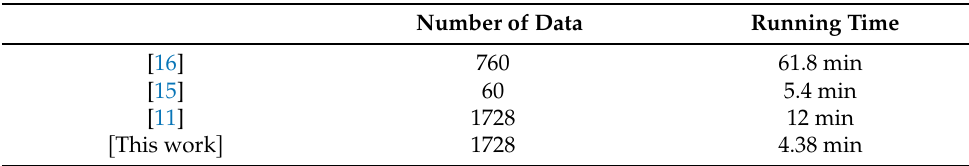
Table 6. Running time comparison of our P k NC and the existing P k